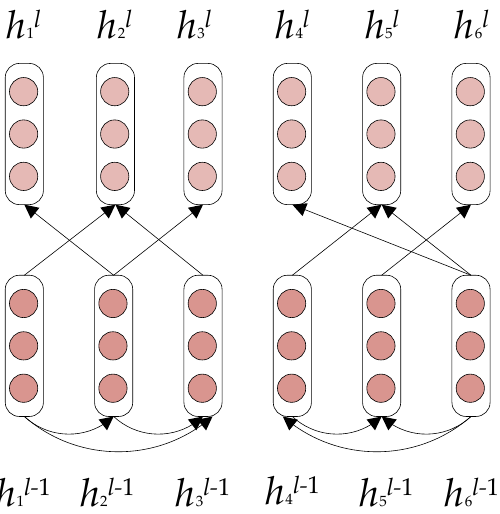
Figure 2. An example of a single-layer GCN.